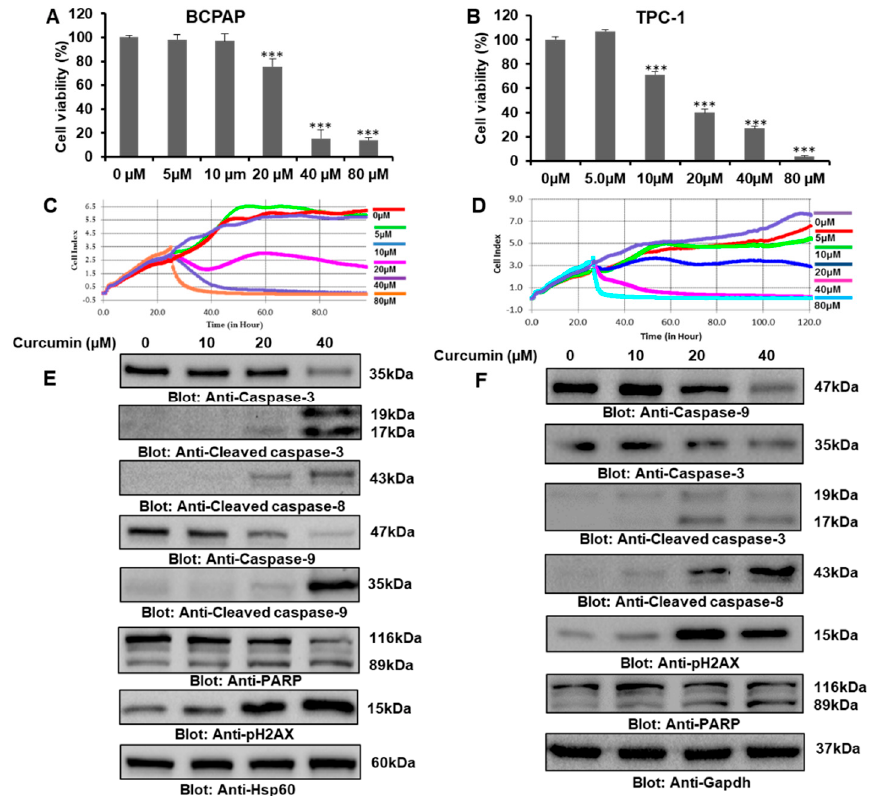
Figure 1. Curcumin-mediated inhibition of cell proliferation and apoptosis in PTC cells. ( A , B ) Curcumin inhibited the cell viability of PTC cell lines BCPAP and TPC-1. PTC cells were treated with 0 µ M, 5 µ M, 10 µ M, 20 µ M, 40 µ M, and 80 µ M of curcumin for 24 h. A cell proliferation assay was performed using a Cell Counting Kit-8 (CCK-8), as described in “Materials and Methods”. Values are expressed as the mean +/ − the SD (standard deviation) of at least six replicates, with a p -value of *** p < 0.001. ( C , D ) Real-time cell proliferation (cell index) analysis of BCPAP and TPC-1 cells, respectively, treated with di ff erent doses of curcumin. Cells were cultured on electrodes and treated with curcumin followed by the monitoring of real-time cell growth, as mentioned in the material and methods section. ( E , F ) Curcumin mediated the inhibition of BCPAP and TPC-1 cell growth and proliferation through apoptosis. PTC cell lines were treated with di ff erent doses of curcumin for 24 h, followed by cell lysis and immunoblotting. Equal amount of proteins were separated using SDS-PAGE, transferred to a Polyvinylidene fluoride or polyvinylidene difluoride (PVDF) membrane, and immunoblotted with antibodies against caspase-3, cleaved caspase-3, cleaved caspase-8, caspase-9, cleaved caspase-9, poly (ADP-ribose) polymerase (PARP), phosphor-histone family member X (p-H2AX), heat shock protein 60 (Hsp60), and Gapdh.